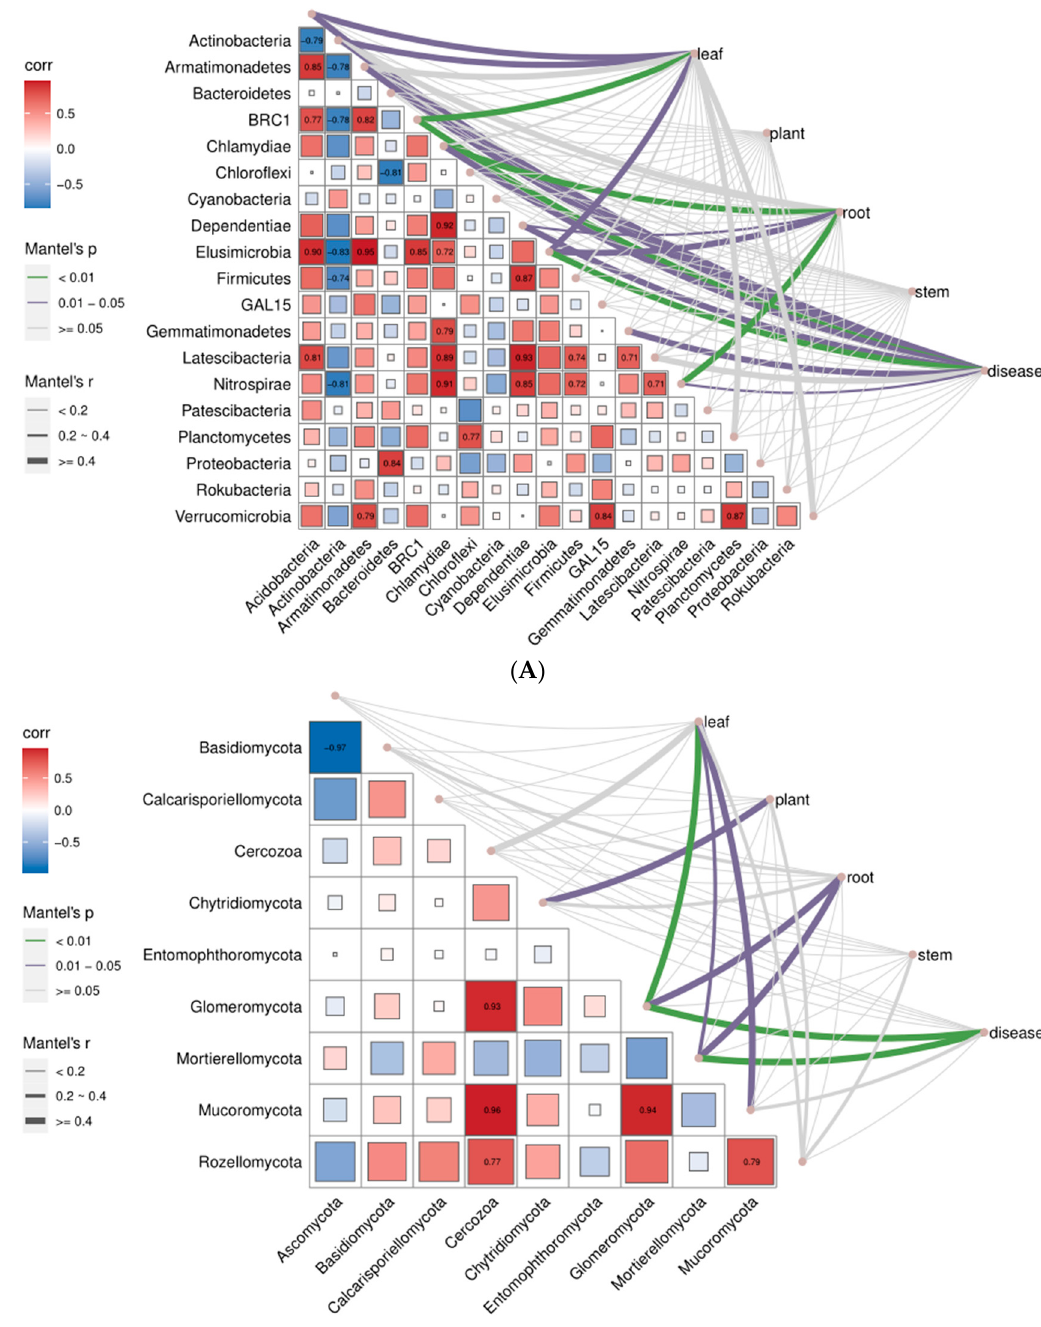
Figure 5. Pairwise comparisons of the phylum-level distribution of the 16S ( A ) and ITS ( B ) root microbiota are shown, with a color gradient that denotes Pearson’s correlation coefficients. Biomass (leaf weight, plant height, root weight, and stem weight) and disease index were correlated with the species of the community using the Mantel test. Edge width corresponds to Mantel’s r statistic for the corresponding distance correlations, and edge color denotes the statistical significance. The concentrations of EO in the soil were 0 mg/g (control), 0.14 mg/g (low concentration), 0.28 mg/g (medium concentration), and 0.56 mg/g (high concentration). The three stages were: EO pretreatment for seven days, then, P. notoginseng was planted and samples were assessed at one and three months. Several bacteria were correlated with saponin content (Figure S3A). Rb1, Rd, and Rg1 were significantly correlated with Firmicutes and Latescibacteria . Rd was correlated with